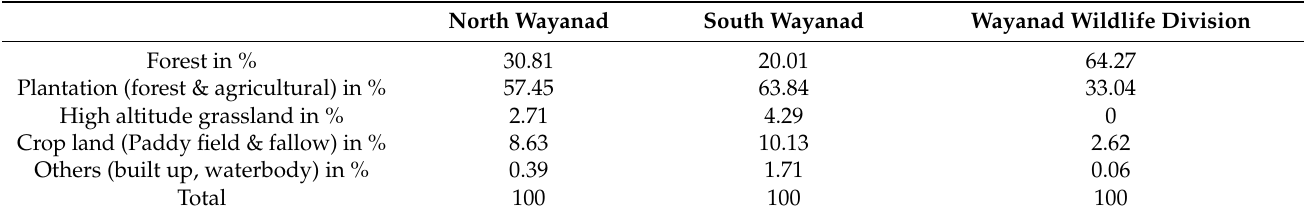
Table 2. Percentage of land use and land cover (LULC) in each forest division in 2018. North Wayanad South Wayanad Wayanad Wildlife Division Forest in % 30.81